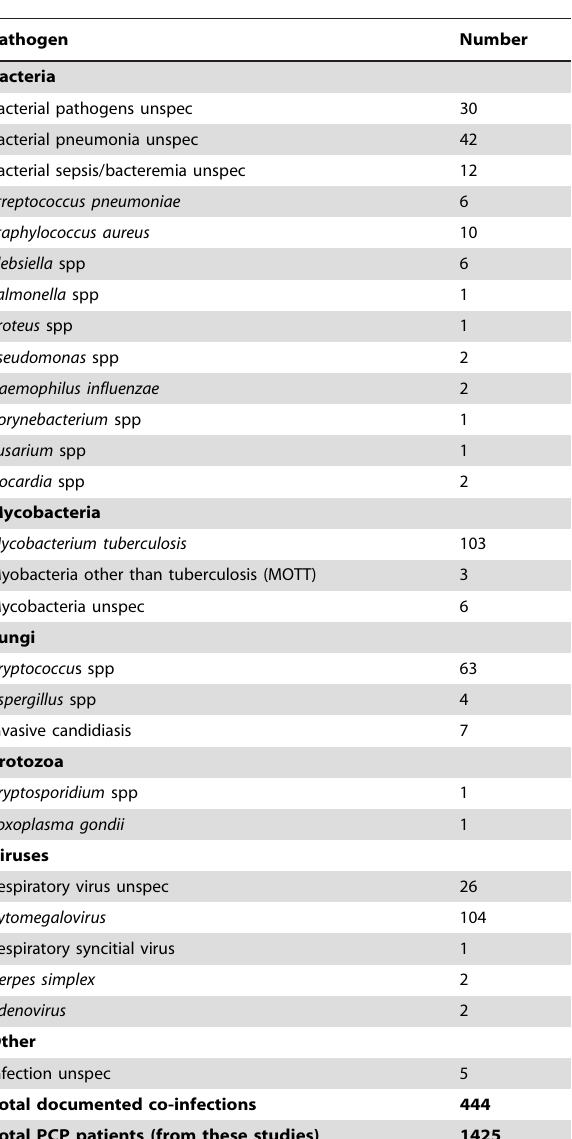
Table 6. Co-infection in PCP